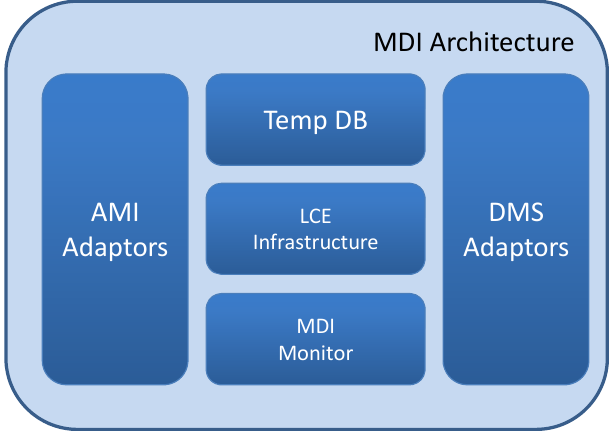
Figure 7. MDI components, as described in